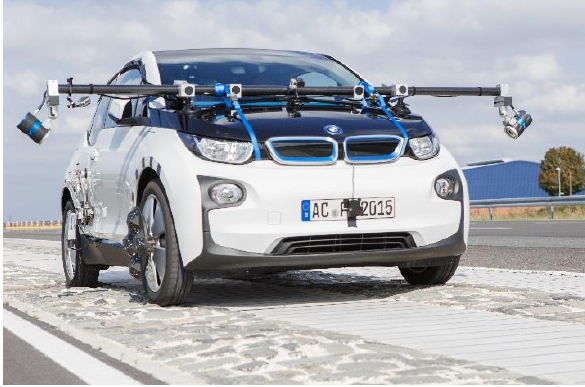
Figure 28: Test drive on Belgian